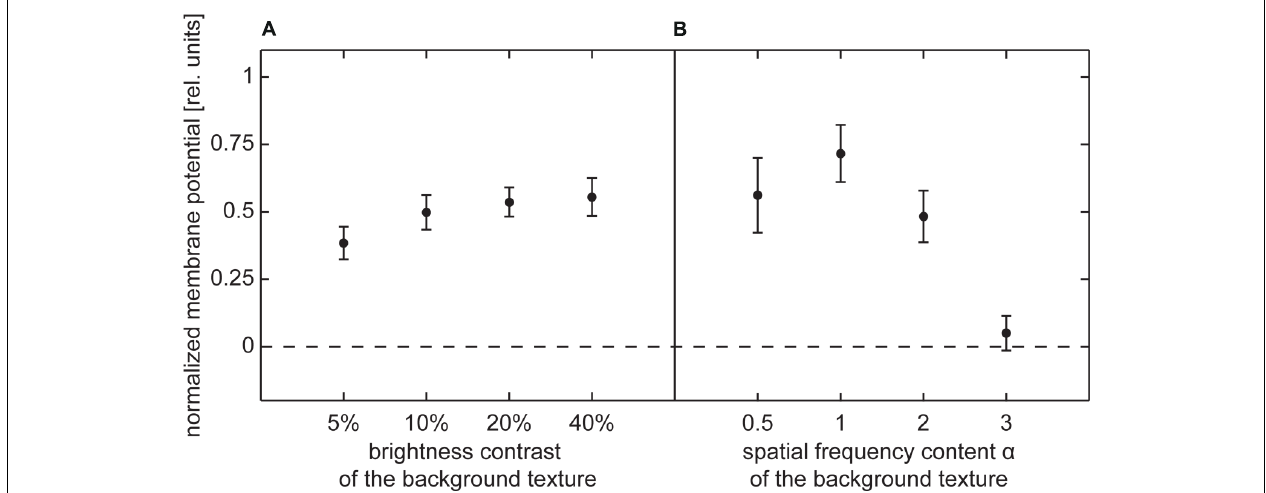
FIGURE 6 | Depolarization level evoked by background texture (no-object condition) during selected intersaccadic intervals. Average depolarization ( ± standard error of the mean) normalized by average depolarization evoked by